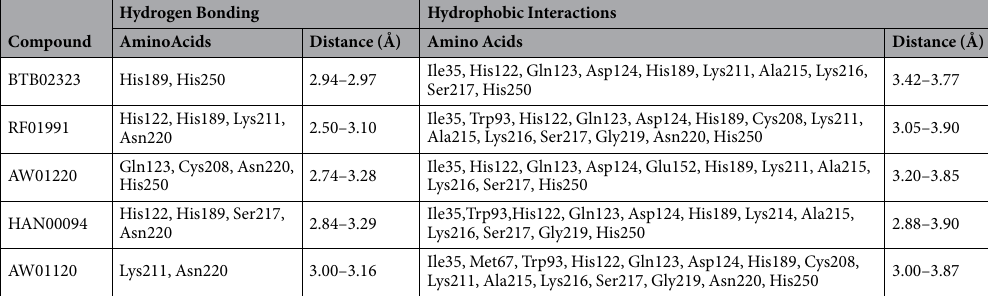
Table 2. NDM-1 hydrogen bonding and hydrophobic